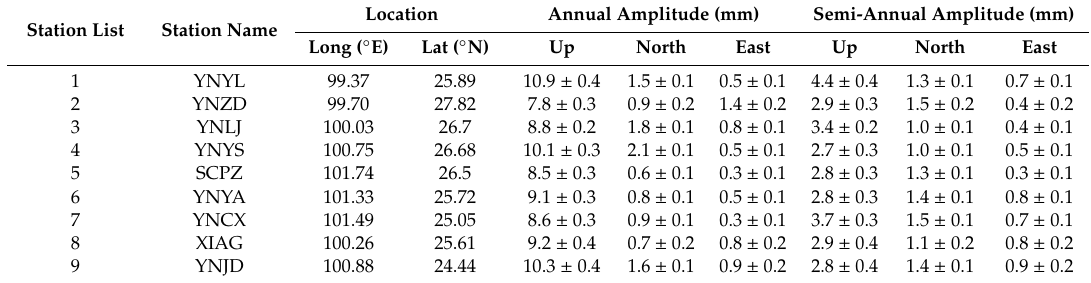
Table 1. The locations of the continuous global positioning system (cGPS) stations and the amplitudes for modeled annual and semi-annual